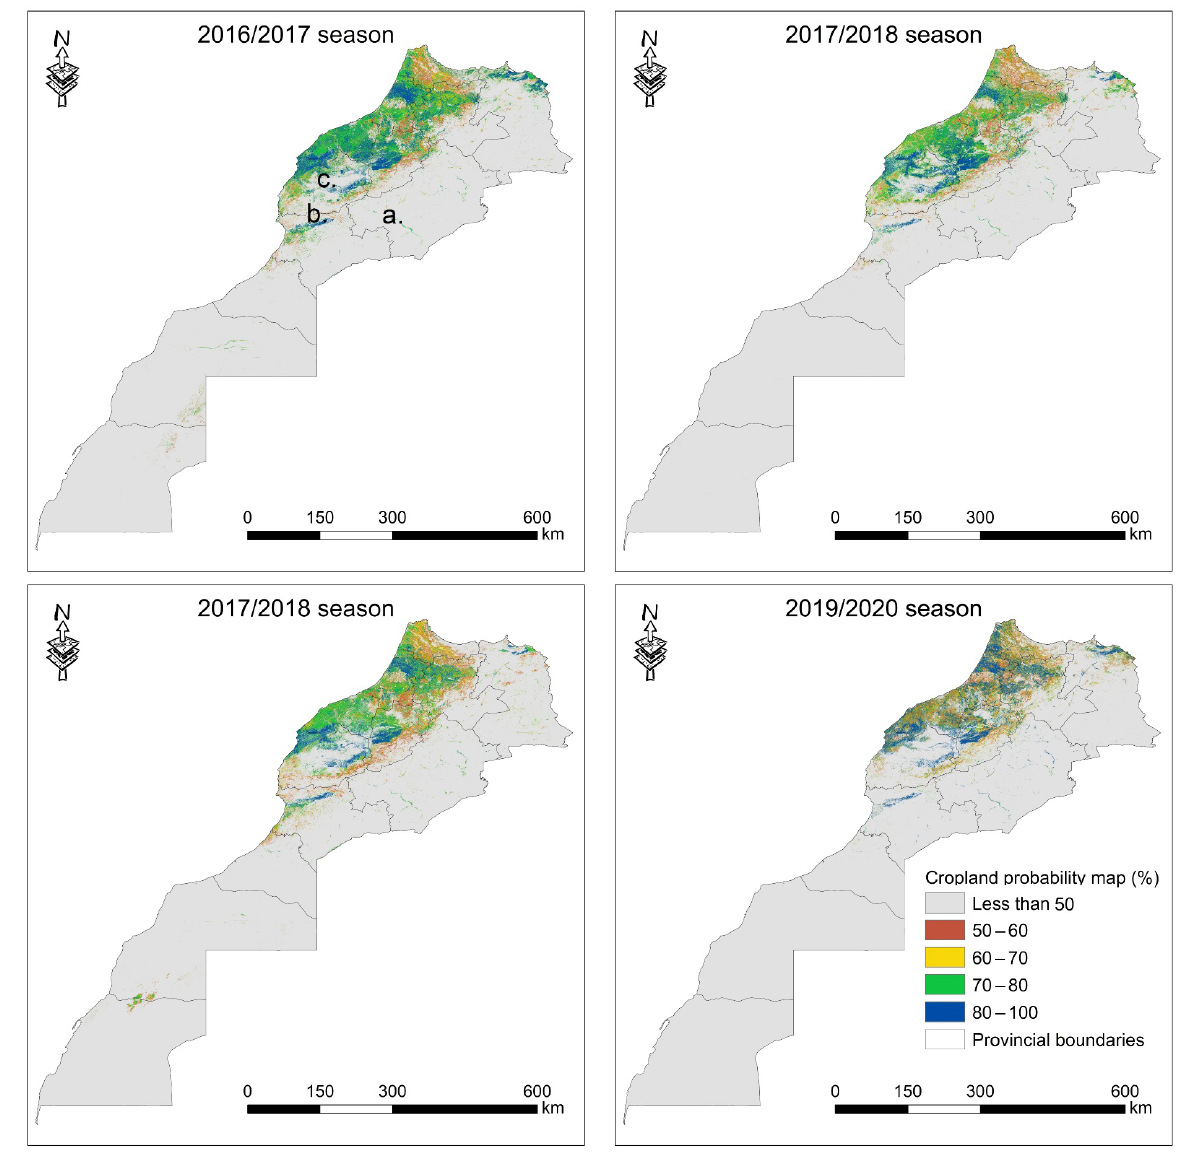
Figure 13. Probability maps of cropland areas, Zoom-ins for a, b, and c Fin panel A are shown in Figure